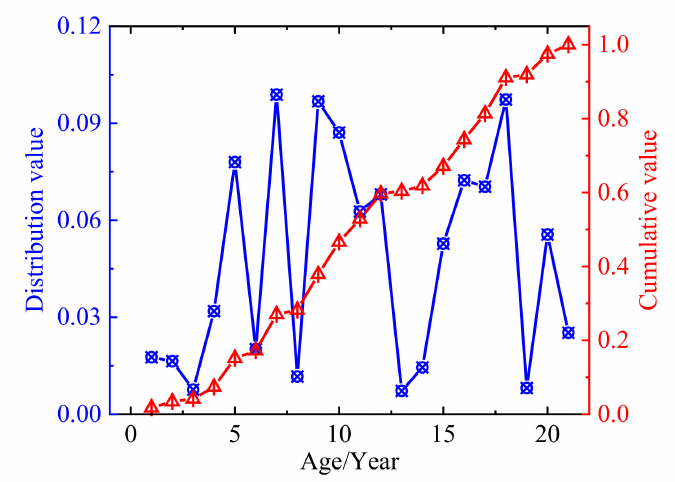
Figure 7. Age distribution of these measured data.